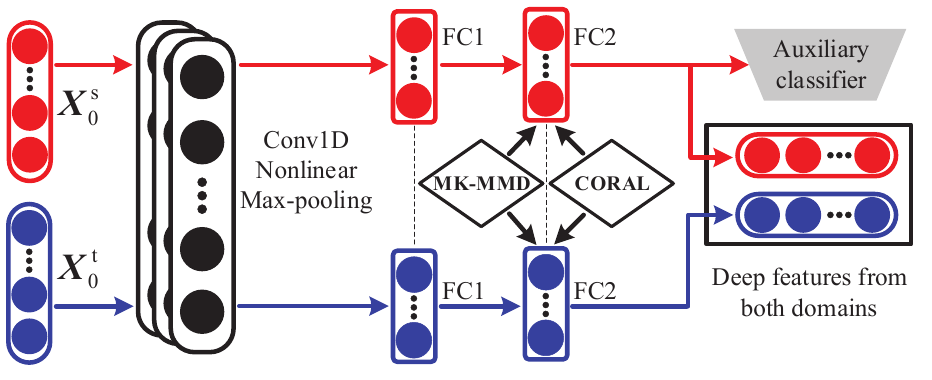
Figure 2. Structure of